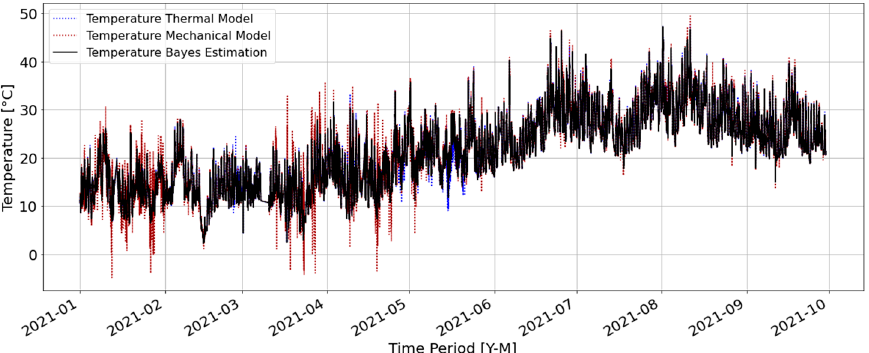
Figure 5. Temperature trends for all analyzed period: thermal model (dashed blue line); mechanical model (dashed red line); Bayesian temperature (black line).